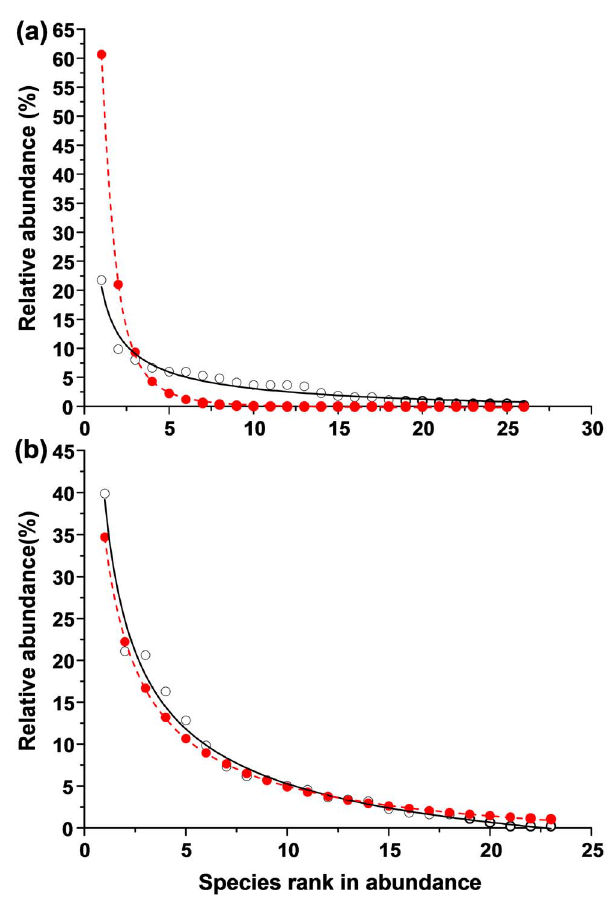
Figure 2. The nonlinear curve fitting of AM fungal abundance versus species rank in abundance in the roots of Ligularia virgaurea (a, x 2 =9.4, df =6, P =0.15; Kolmogorov-Smirnov Z =0.47, P =0.98; estimated parameters, h =1.2, I=7.5) and neighborhood plants (b, x 2 =8.3, df =4, P =0.33; Kolmogorov- Smirnov Z =0.40, P =0.99; estimated parameters, h =9.3, I=3.8). Open circles and solid line represent observed values and their fitted curve, respectively; filled circles and dotted line represent expected values under a neutral model and their fitted curve, respectively.